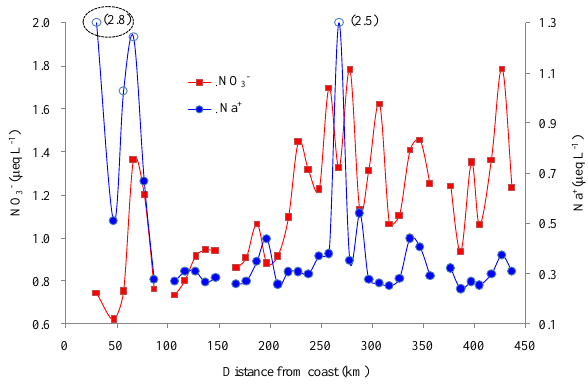
Figure 8. Concentrations of NO 3- and Na + in surface snow samples on the coast. Four samples with high Na + concentrations are denoted by open circles, corresponding to those in Fig. 7b. Note that Na + concentrations in two samples, 2.5 and 2.8 μeq L -1 in parentheses, are above the maximum value of the secondary y -axis (Na + concentration). The sample in the dashed ellipse, with Na + concentration of 2.8 μeq L -1 , is the fresh snowfall.